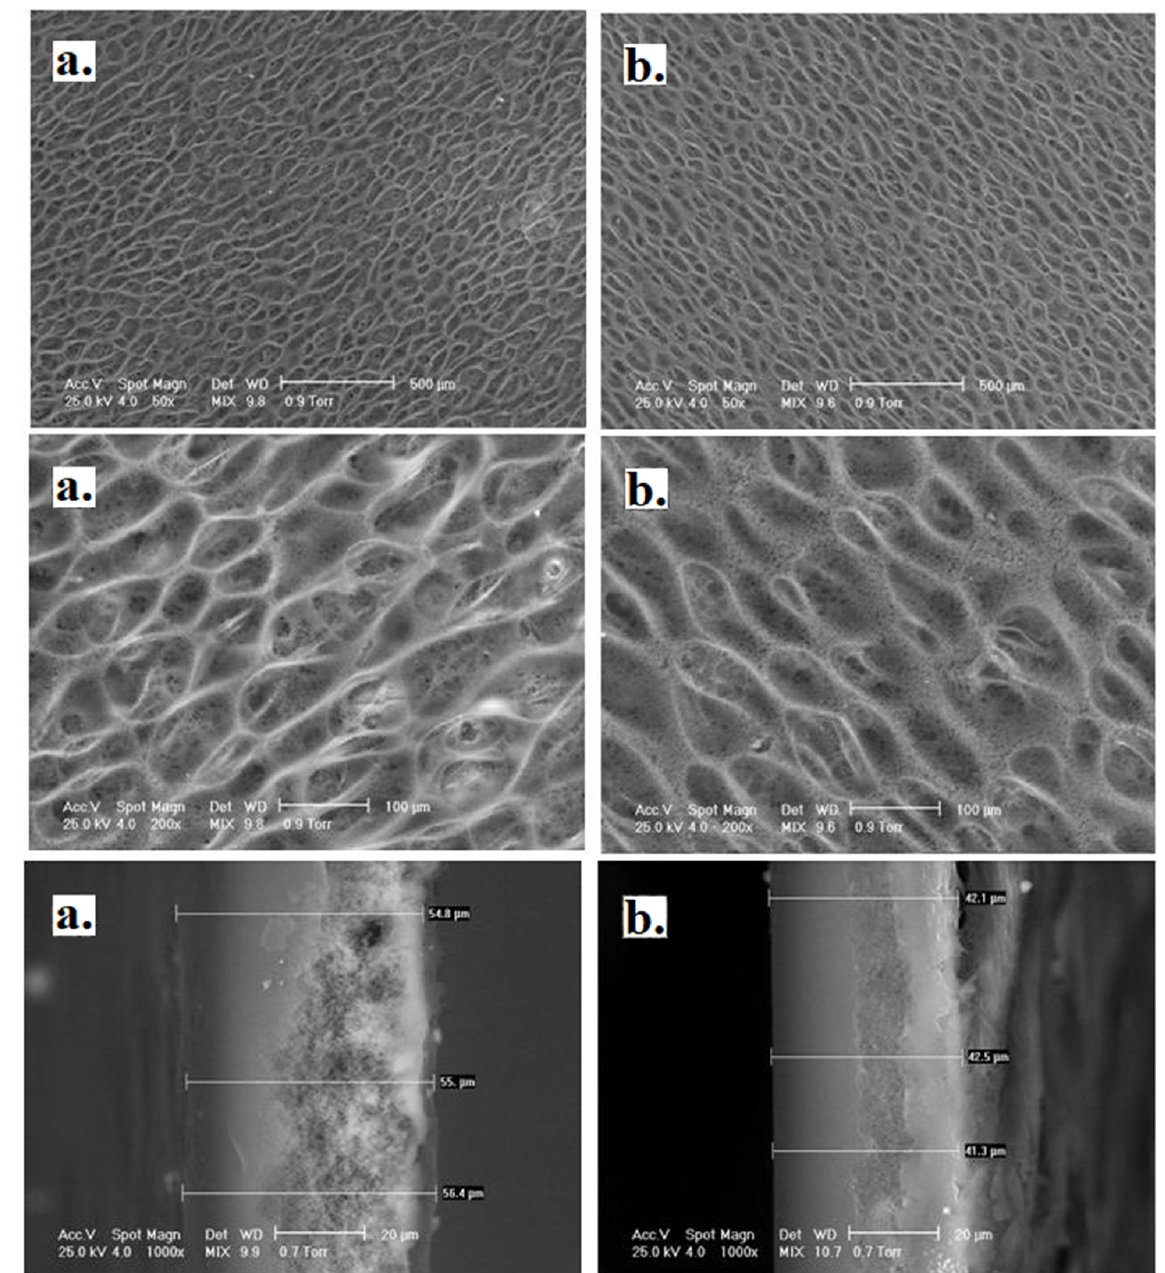
Figure 8. SEM images of PSF ( a) and PSF/rGO-NH 2 –CE ( b ), top view at two magnification values (50× and 200×), and cross-section (100×).